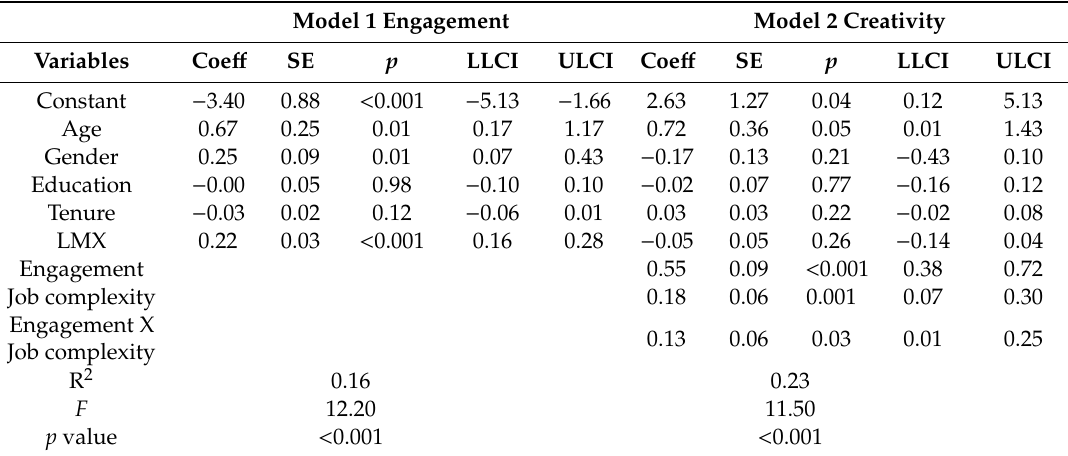
Table 3. Coe ffi cients for the conditional process model.